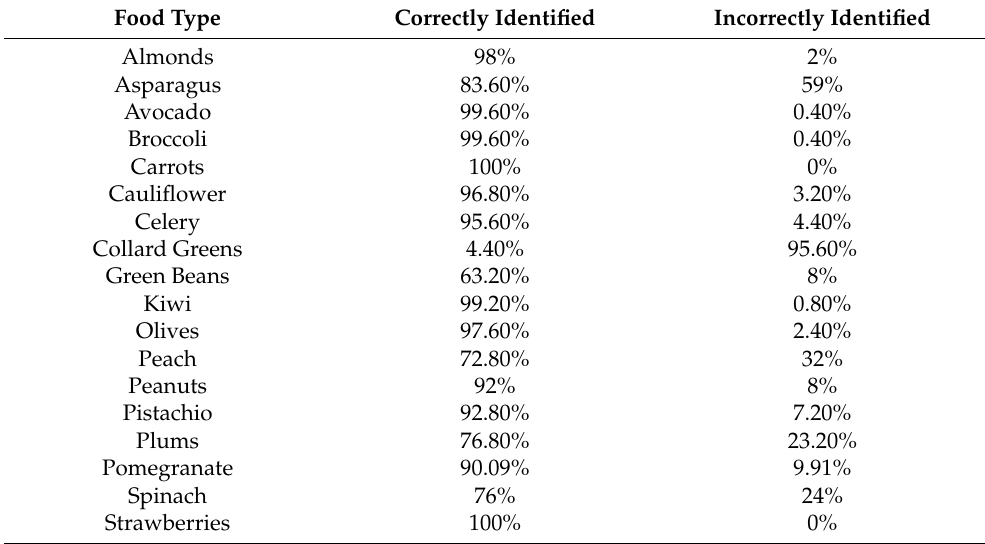
Table 1. Food identification results in name-blinded sensory